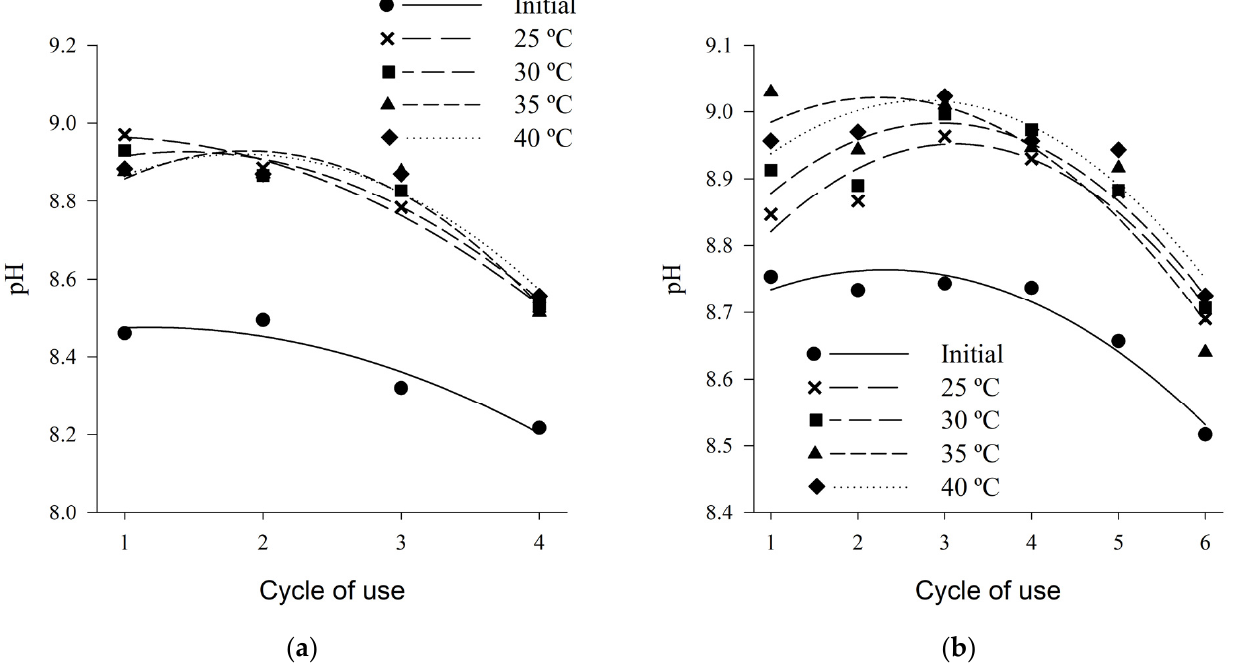
Figure 6. pH of wood shaving bed ( a ) and coffee husk bed ( b ) samples in different cycles of use and heat treatments.